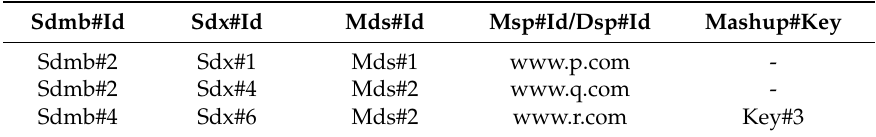
Table 7. Structured Data Mashup Box Mashup Data Services (SDMB-MDS)